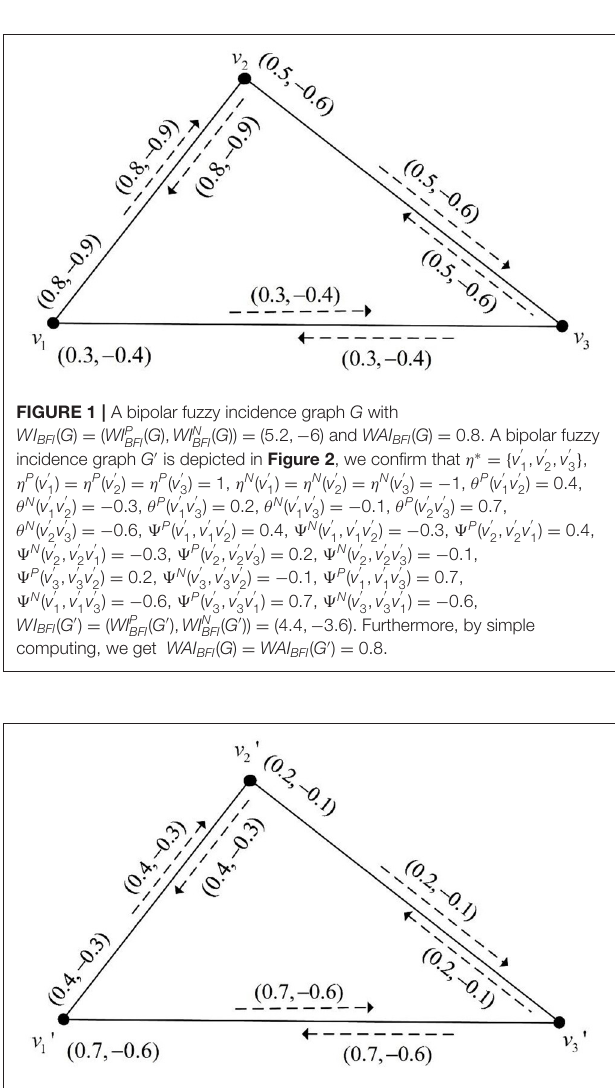
FIGURE 2 | A bipolar fuzzy incidence graph G ′ with WI BFI ( G ′ ) = ( WI P BFI ( G ′ ), WI N BFI ( G ′ )) = (4.4, − 3.6) and WAI BFI ( G ′ ) = 0.8.